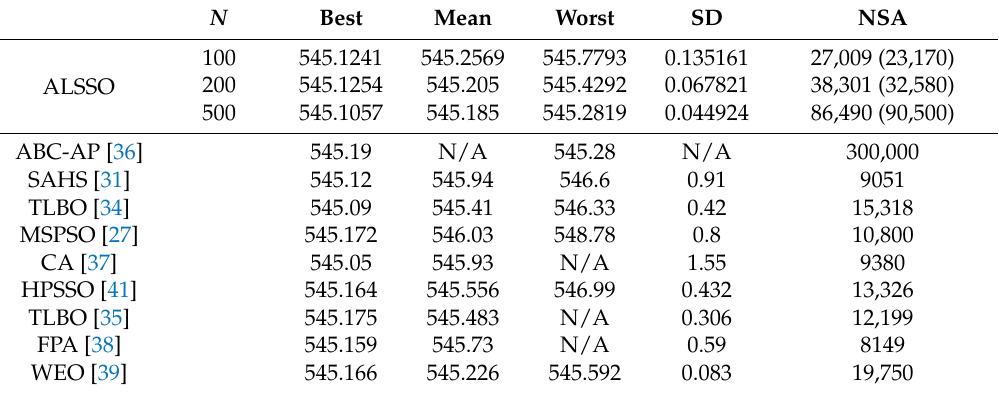
Table 6. Comparison of statistical performance in the 25-bar truss problem.